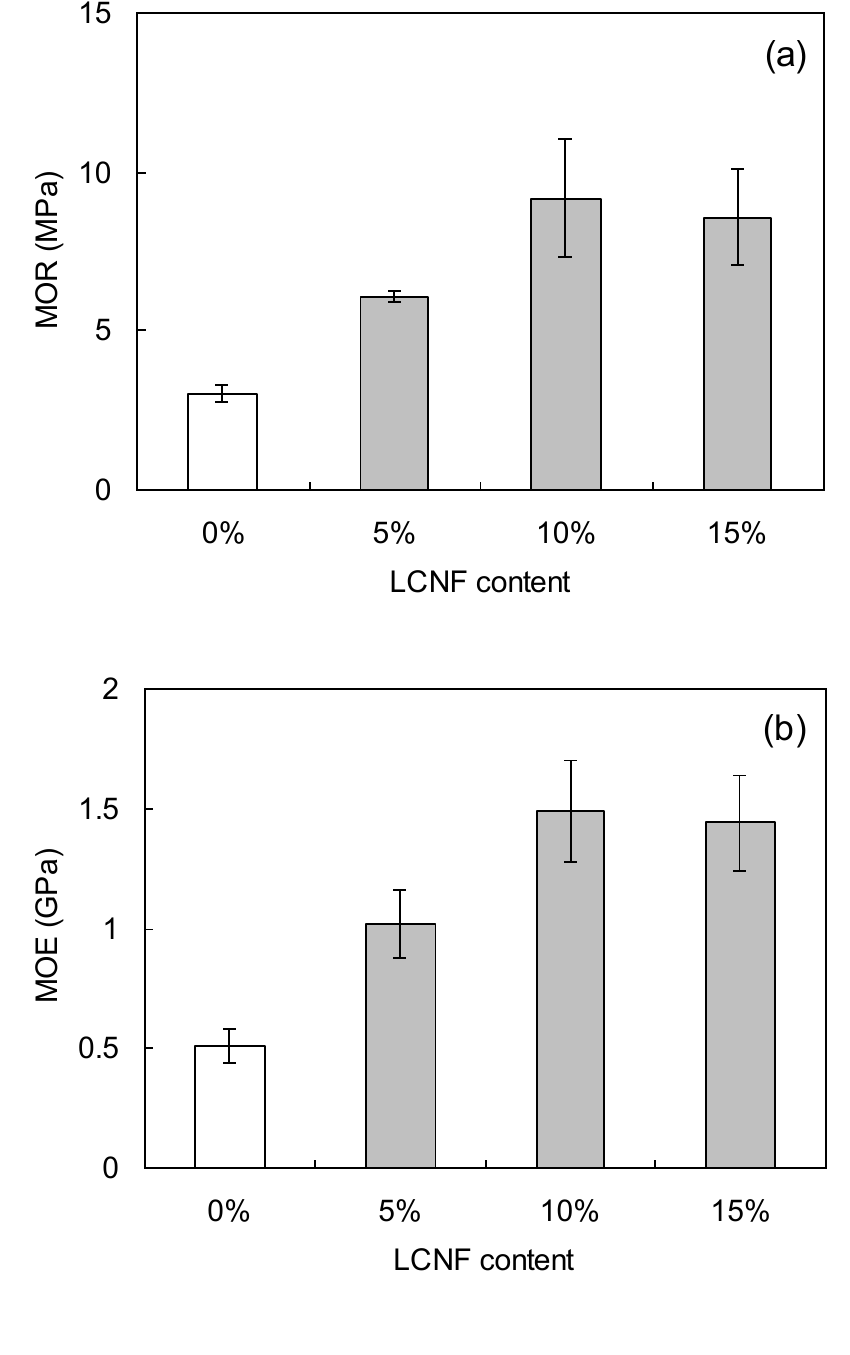
Figure 5. The bending properties, ( a ) modulus of rupture (MOR) and ( b ) and modulus of elasticity (MOE) are given for W8 composites as a function of LCNF content. The vertical bars indicate a single standard